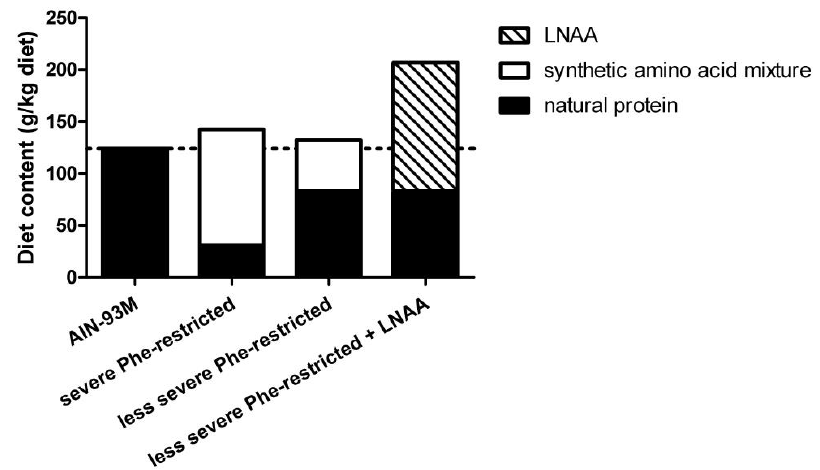
Figure 1. Protein contents of the various experimental diets. The dashed line indicates the total protein content of the AIN-93M control diet.